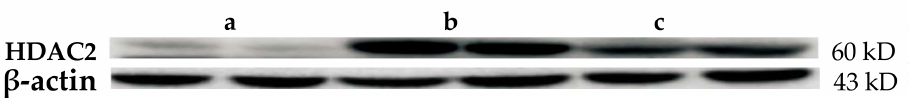
Figure 3. The protein expression of HDAC2 in different groups (( a ) LO2 cells; ( b ) HepG2 cells; and ( c ) Compound 1 on HepG2 cells).